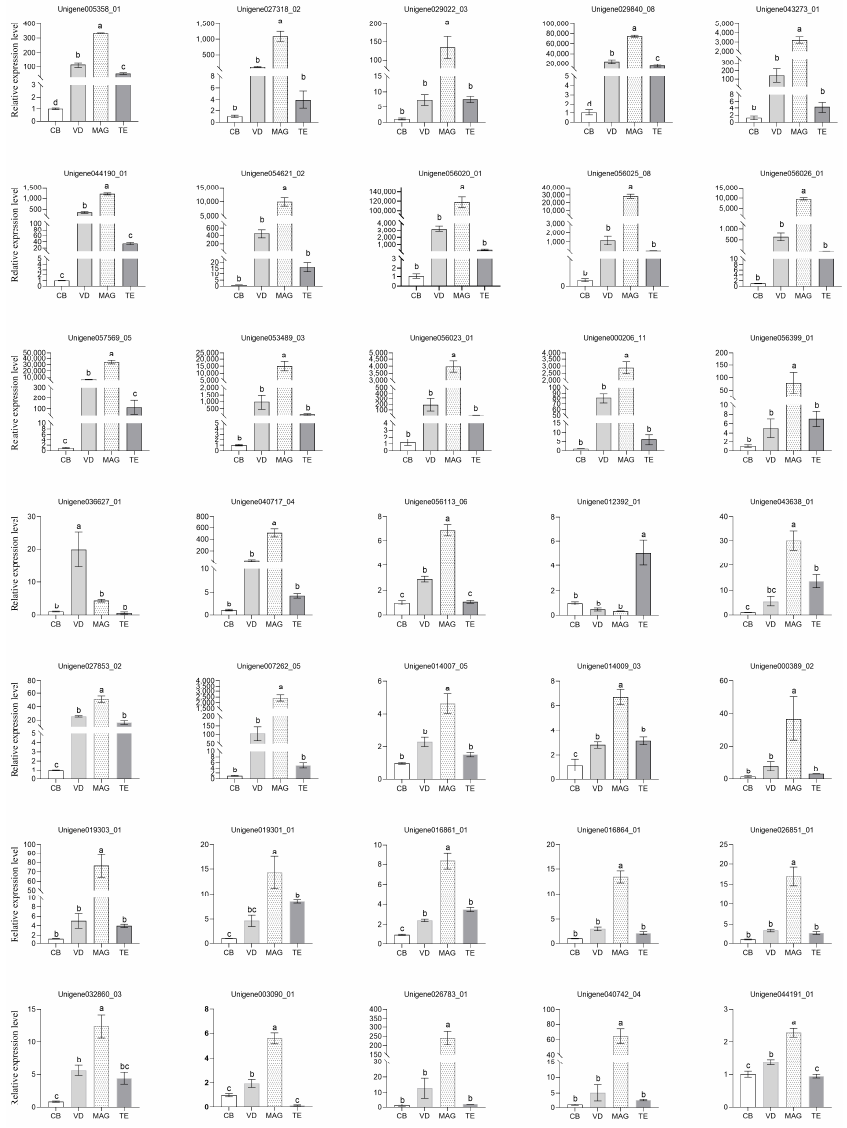
Figure 6. Analysis of the gene expression profiles of accessory gland proteins by qRT-PCR. The X-axis shows the different tissues, including testis (TE), male accessory gland (MAG), vas deferen (VD), and female copulatory bursa (CB). The Y-axis shows the relative mRNA expression level. All data are expressed as the means ± standard error (SE). Relative expression levels were calculated based on the value in CB tissue, which was ascribed an arbitrary value of 1. Different letters above the bars indicate significant differences based on Duncan’s test at a significance level p <